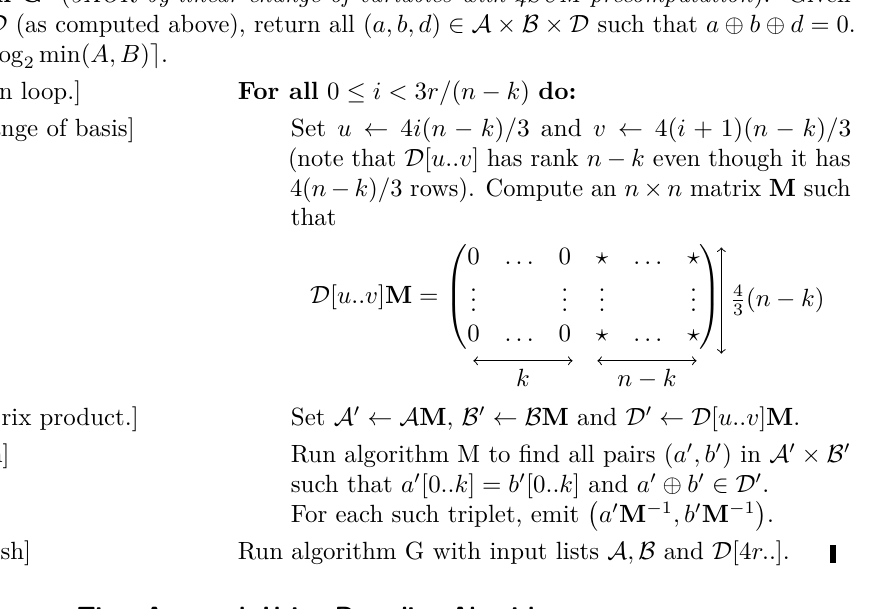
Algorithm G’ ( 3XOR by linear change of variables with 4SUM precomputation ).